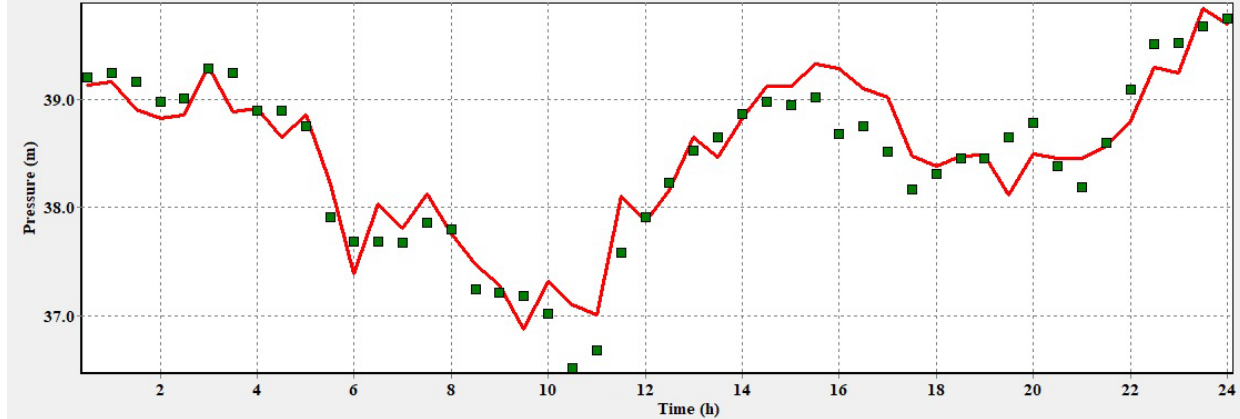
Figure 13. Pressure profile at P14.